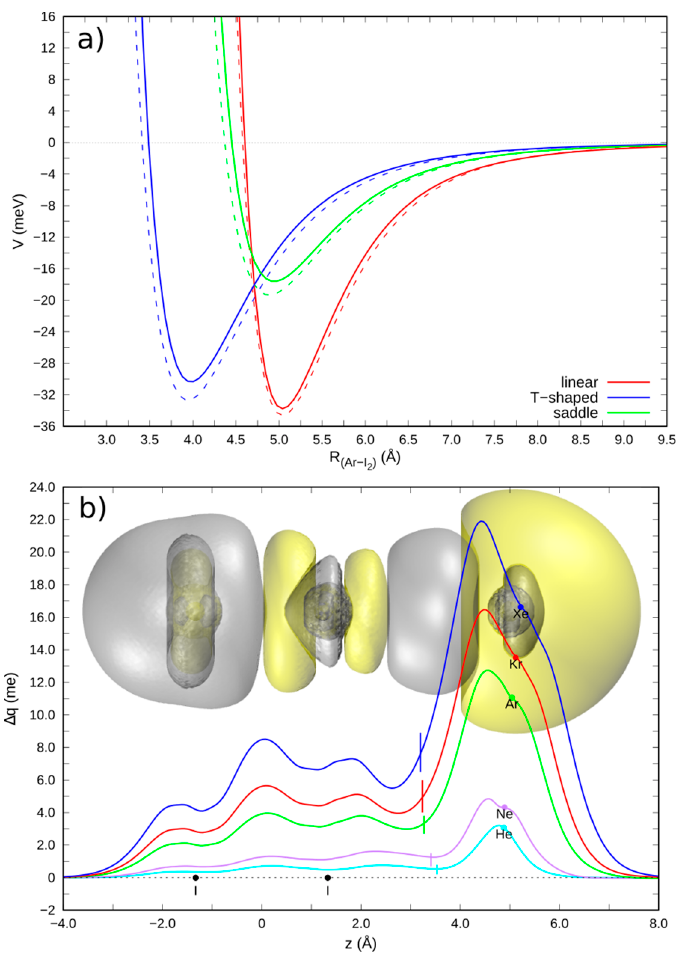
Figure 2. ( a ) Potential energy curves (interaction potential V vs. Ar-I 2 distance R ) for the selected ground state Ar-I 2 complexes in the three configurations [solid lines, CCSD(T) / AV5Z level of theory; dashed lines, curves from semi-empirical model]. ( b ) CD curves of the ground state Ng-I 2 complexes in the linear configuration - dots represent the atomic nuclei position on the z axis and vertical lines mark the isodensity boundaries. The inset shows the 3D isodensity plots of the electron density change, accompanying bond formation ( ∆ ρ = 8 · 10 − 6 me / bohr 3 , negative / positive values in yellow / silver). (adapted from Reference 17).